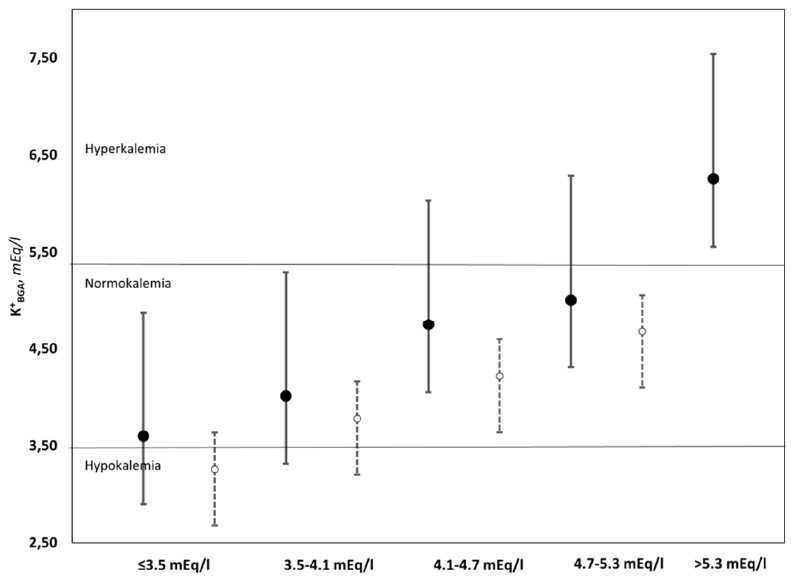
Figure 4. Comparison between the means and respective systematic errors of the hemolyzed ( ● ) and non-hemolyzed ( ○ ) samples, divided into five ranges of values and three clinical conditions.